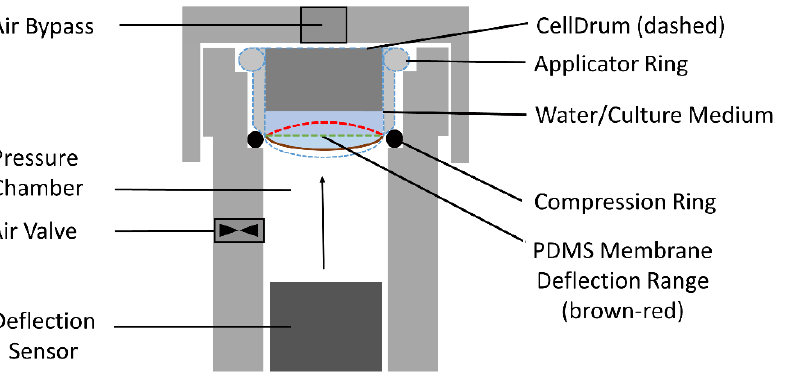
Figure 3. Schematic cross-section of the deflection measurement system. The contour of the CellDrum is shown dashed in blue. The PDMS membrane forms the lower part of the CellDrum. The figure indicates three membrane positions: Brown and red mark the lower and upper limits, respectively, of the membrane bending range used for the measurement. Green marks the flat membrane condition, i.e., the strain minimum. The membrane curvature is determined by the pressure in the pressure chamber, the membrane properties (PDMS membrane with attached cell culture layer) and the weight of the water/medium above the membrane in the CellDrum.